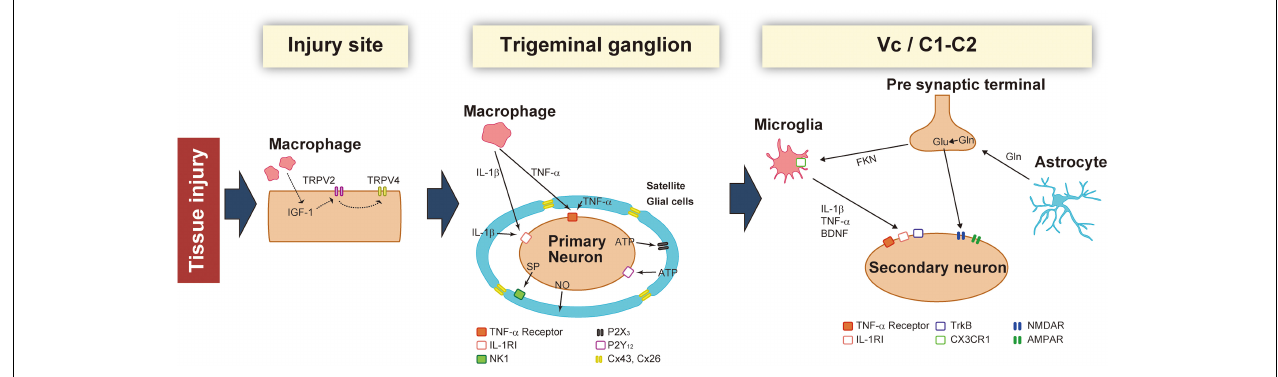
FIGURE 1 | Schematic illustration of the changes that occur in the injured site, trigeminal ganglion (TG), and Vc/C1-C2 following trigeminal nerve injury. After nerve injury, macrophages sensitize TG neurons by activating peripheral nerves and the soma. In the TG, neuronal activity is potentiated by secretory factors from satellite glial cells. Activated glial cells such as microglia and astrocytes further enhance synaptic transmission in the Vc and